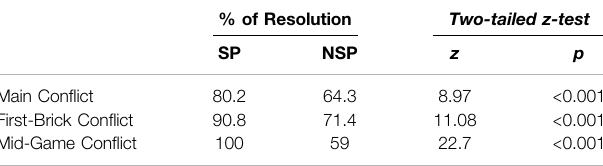
TABLE 2 | Results of the simulation of the experiment with the fair NSP robot behaviour. The statistics are applied on the simulated data. % of